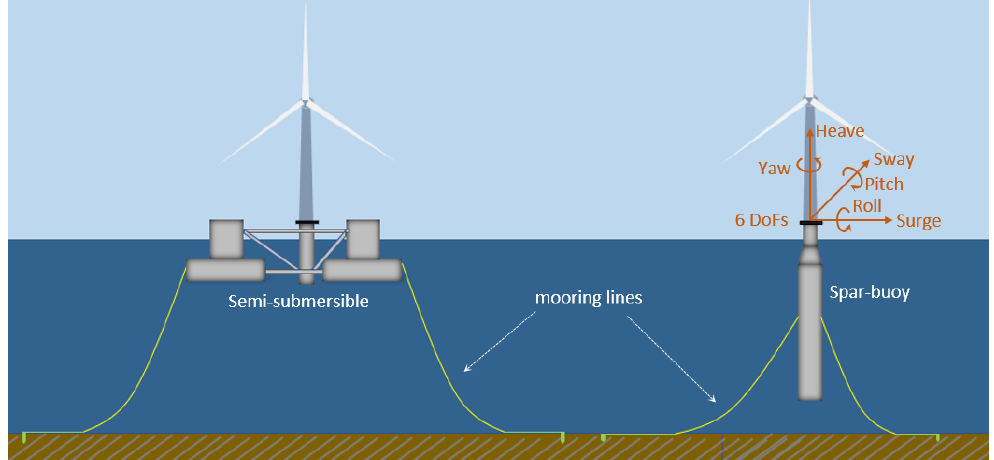
Figure 1. Overall configuration of the semi-submersible and spar-buoy offshore wind